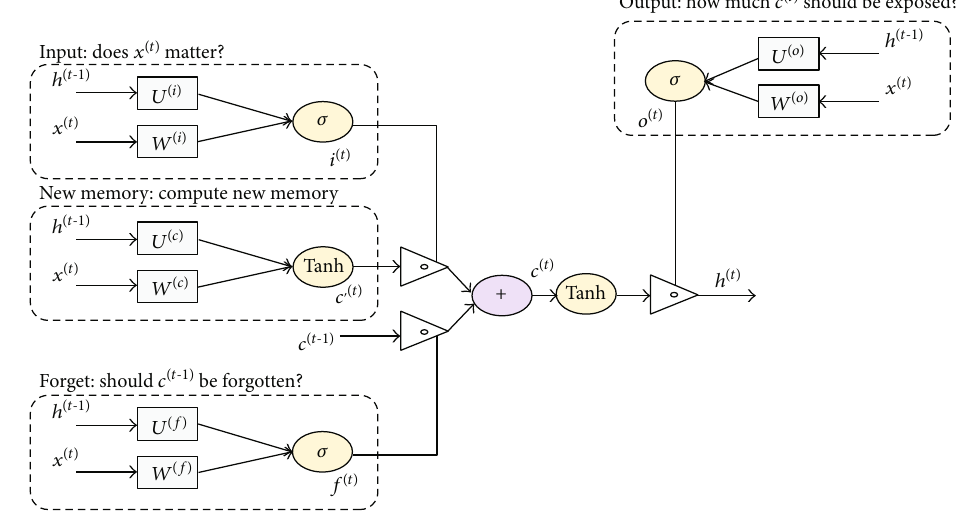
Figure 2: Structure of LSTM model.